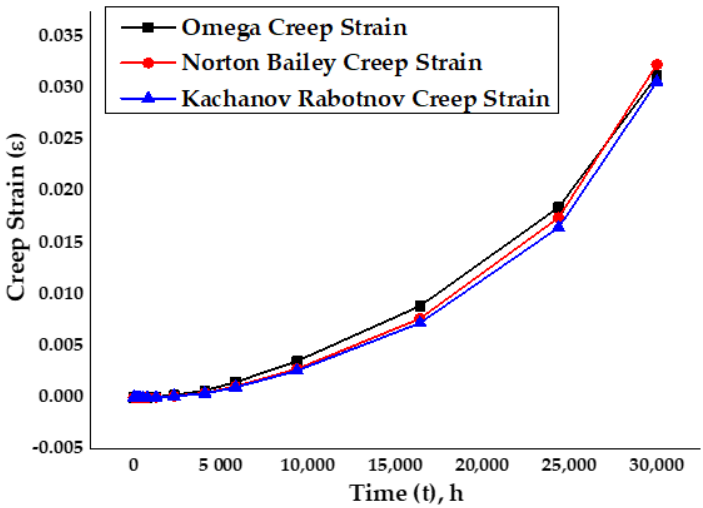
Figure 14. Omega model analytical vs Norton–Bailey and Kachanov–Rabotnov creep strains.